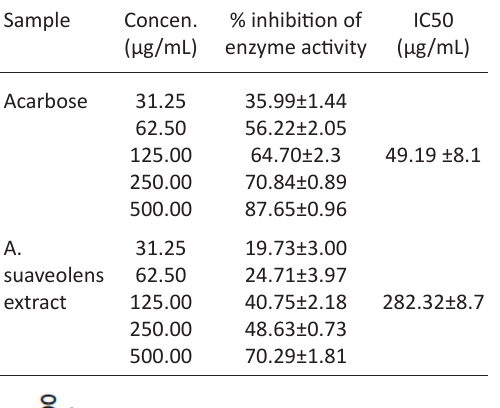
Table 2. Inhibition of α -Glucosidase enzyme activity by A. suaveolens extract